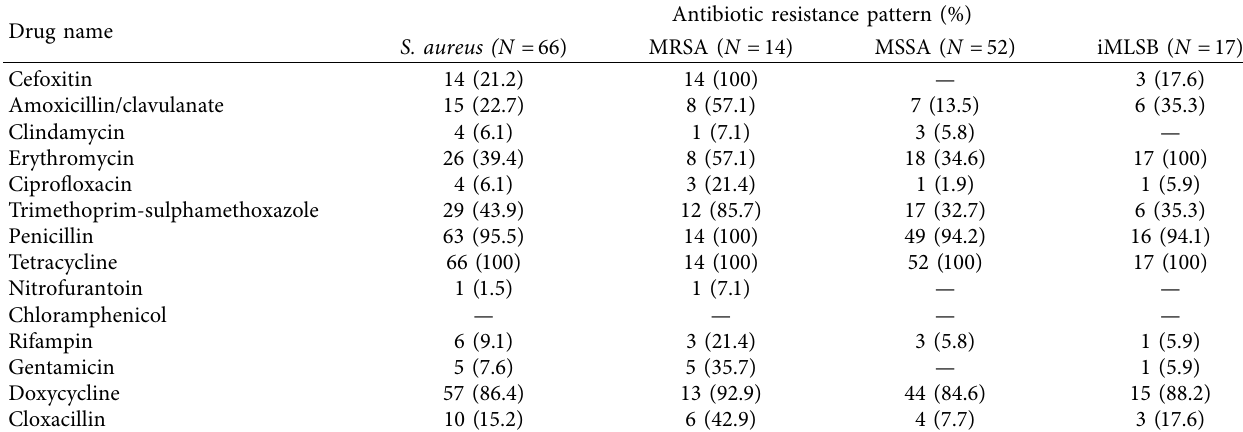
Table 2: Antibiotic resistance pattern of S . aureus isolated from patients attending University of Gondar Comprehensive Specialized Hospital, Ethiopia,